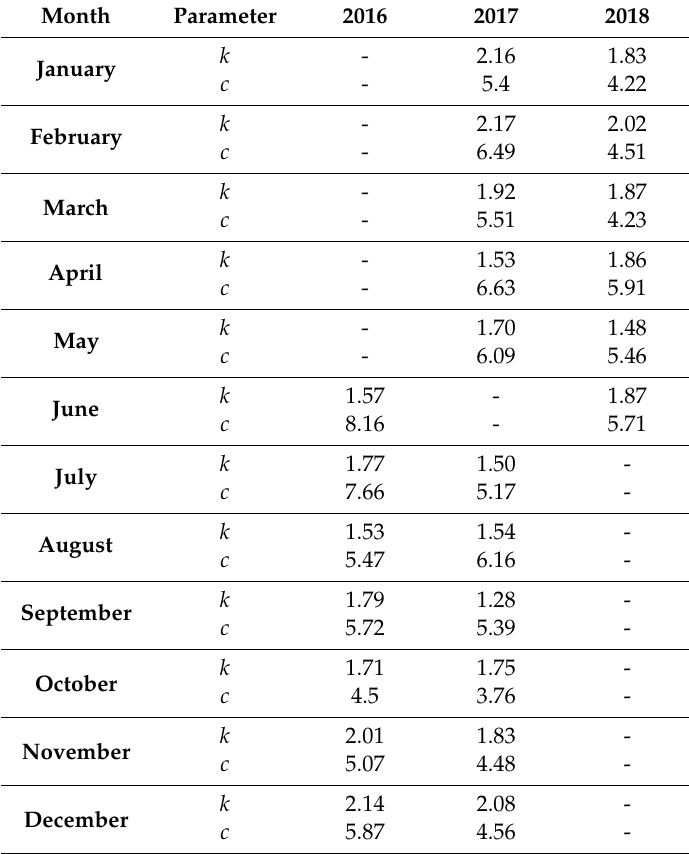
Table 4. Weibull